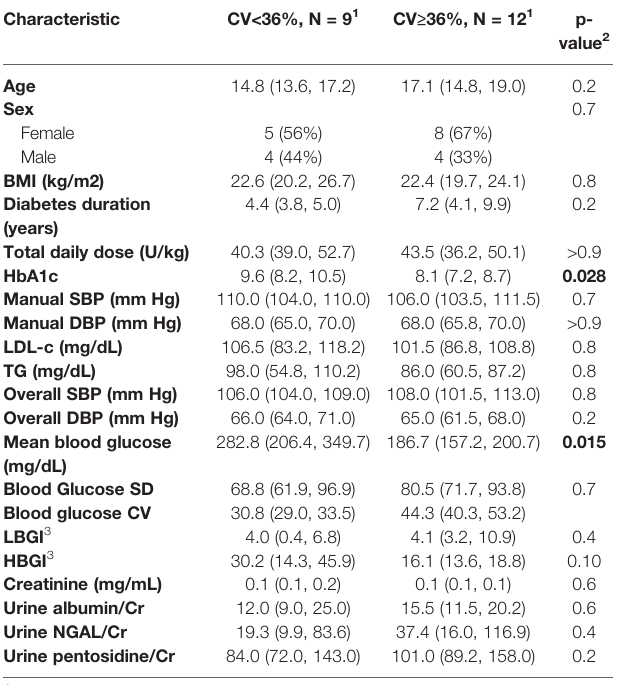
TABLE 6 | Baseline characteristics of the case group with high glycemic variability (BG CV ≥ 36%) and group with low variability (BG CV<36%). Characteristic